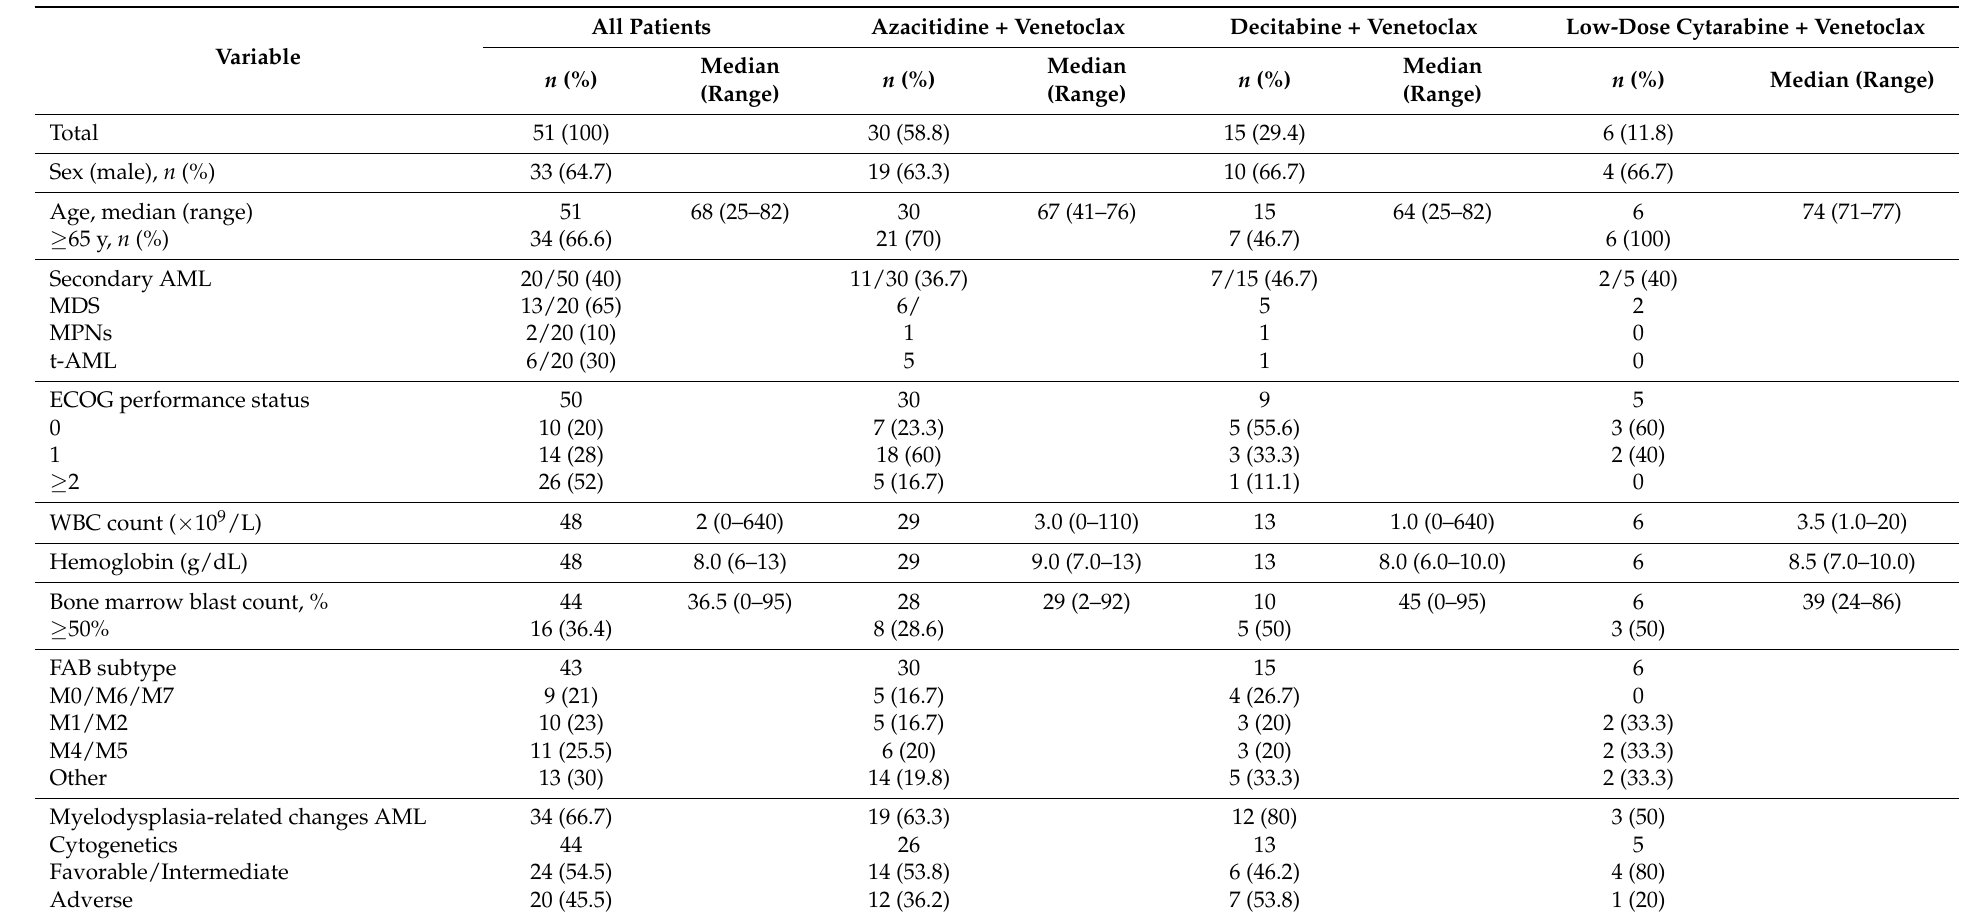
Table 1. Main patients’ characteristics prior to venetoclax